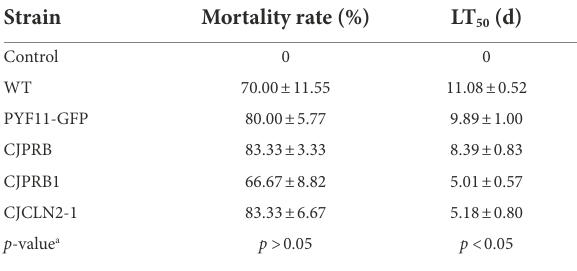
TABLE 5 Insect bioassay of C . javanica wild-type transformant strains (mean ± SE). Strain Mortality rate